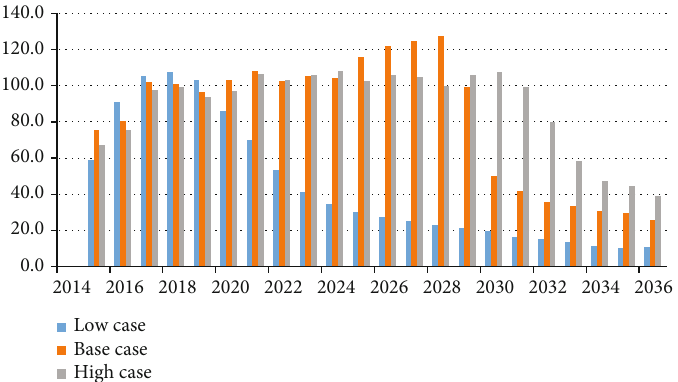
Figure 4: Greater Jubilee full fi eld gas production,